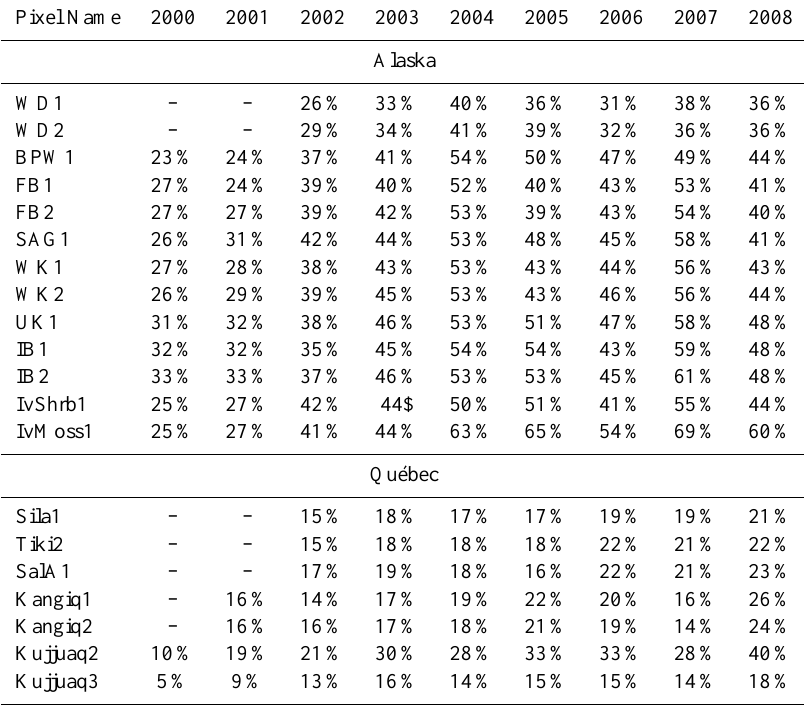
Table 4. Number of days (percentage) with clear-sky MODIS LST measurements